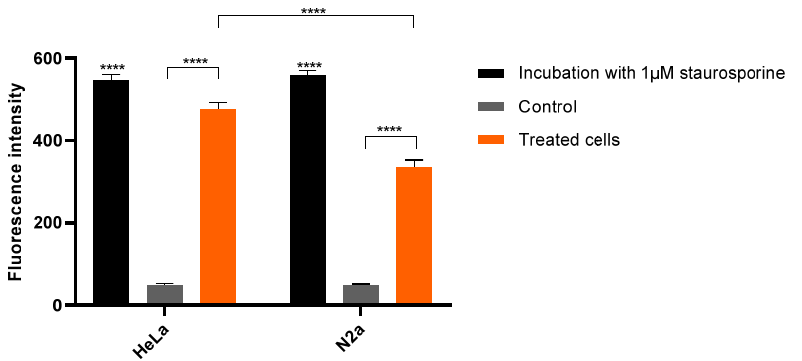
Figure 7. Caspase-3 activity in HeLa and N2a cancer cells after 48 h of transfection mediated by PAMAM G4-PTX/pDNA/PEI vectors at N/P ratio of 50:2:1. Incubation with 1 µ M of staurosporine for 48 h was used as positive control. Data are presented as mean ± SD, n = 6, and analyzed by two- way ANOVA followed by Bonferroni test.